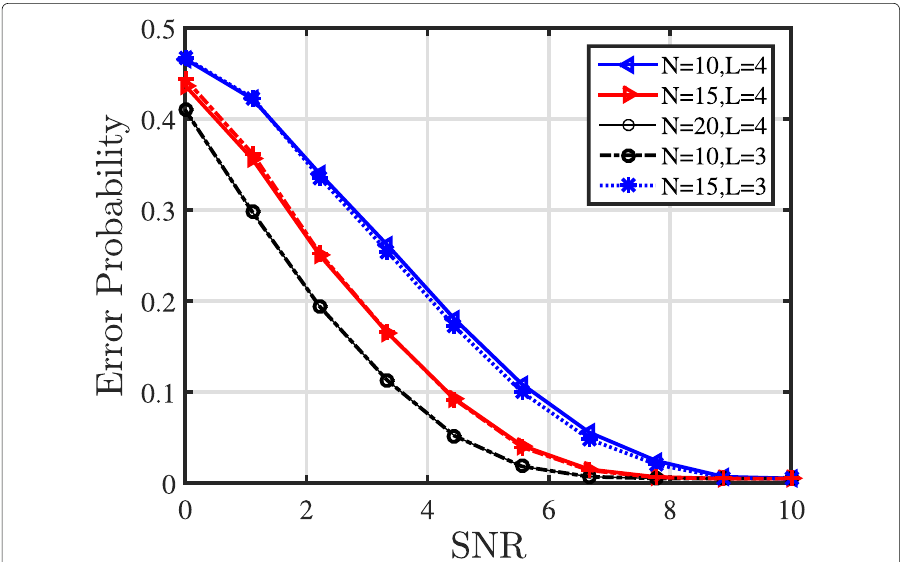
Fig. 5 Error probability of GWT classier for different channel conditions and number of observation vectors for D = {8PSK,QPSK}